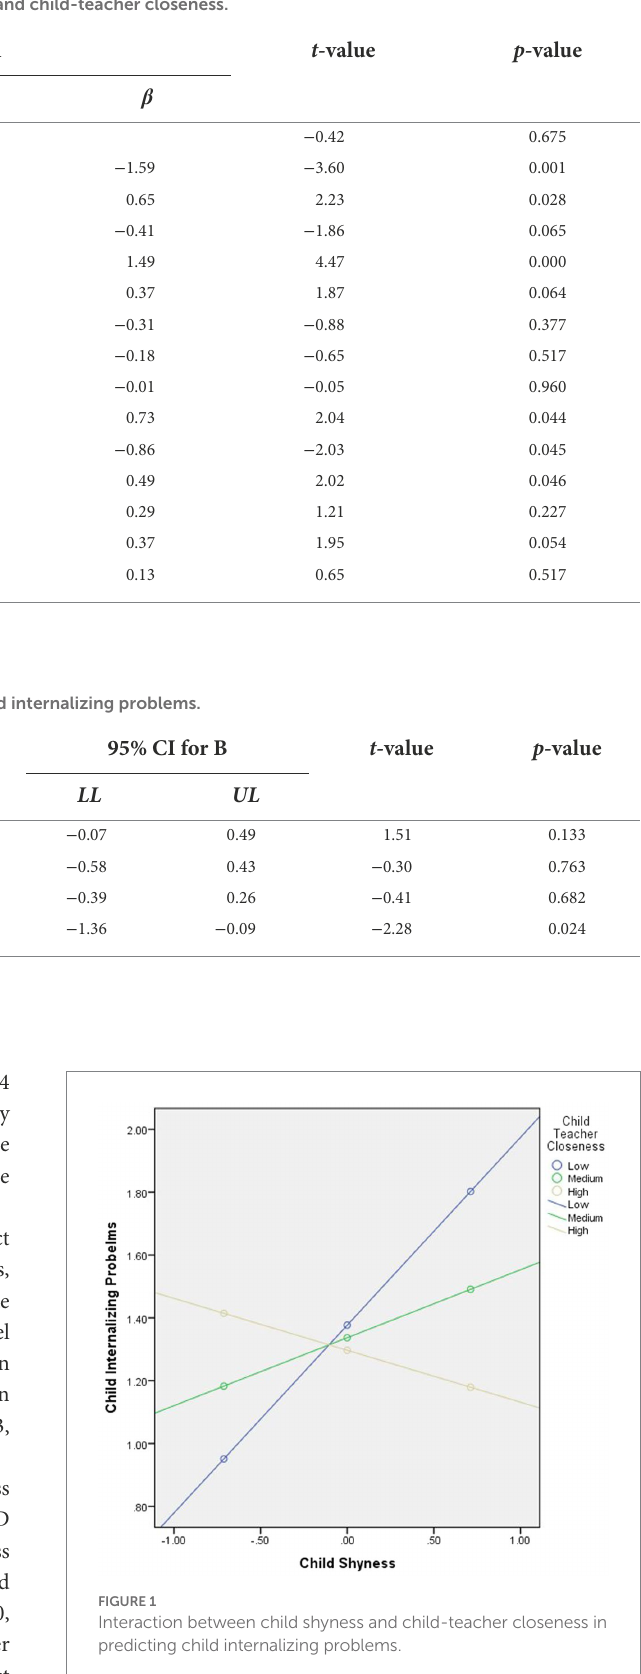
TABLE 6 Hierarchical regression coefficients for child temperament and child-teacher closeness.